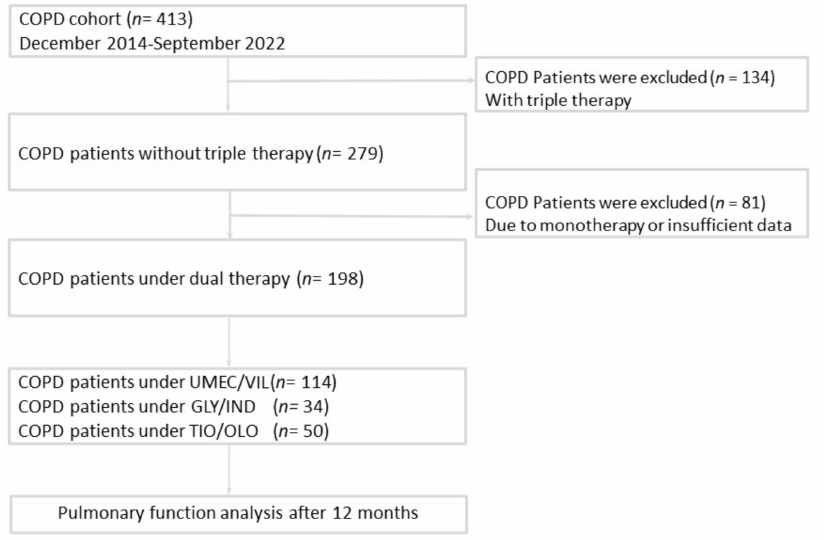
Figure 1. Patient enrollment flowchart. COPD: chronic obstructive pulmonary disease; UMEC/VIL: